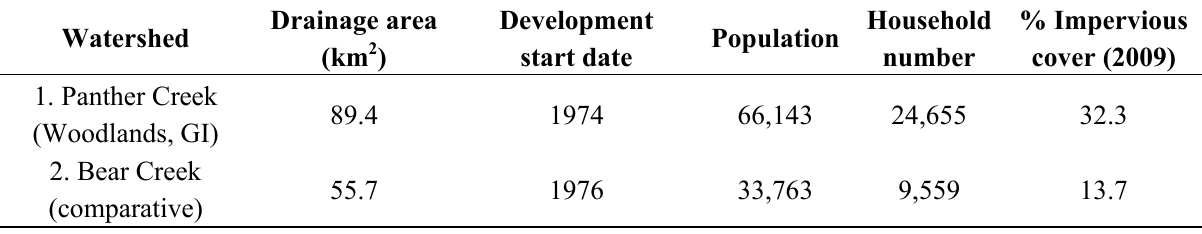
Table 1. Study sites and respective